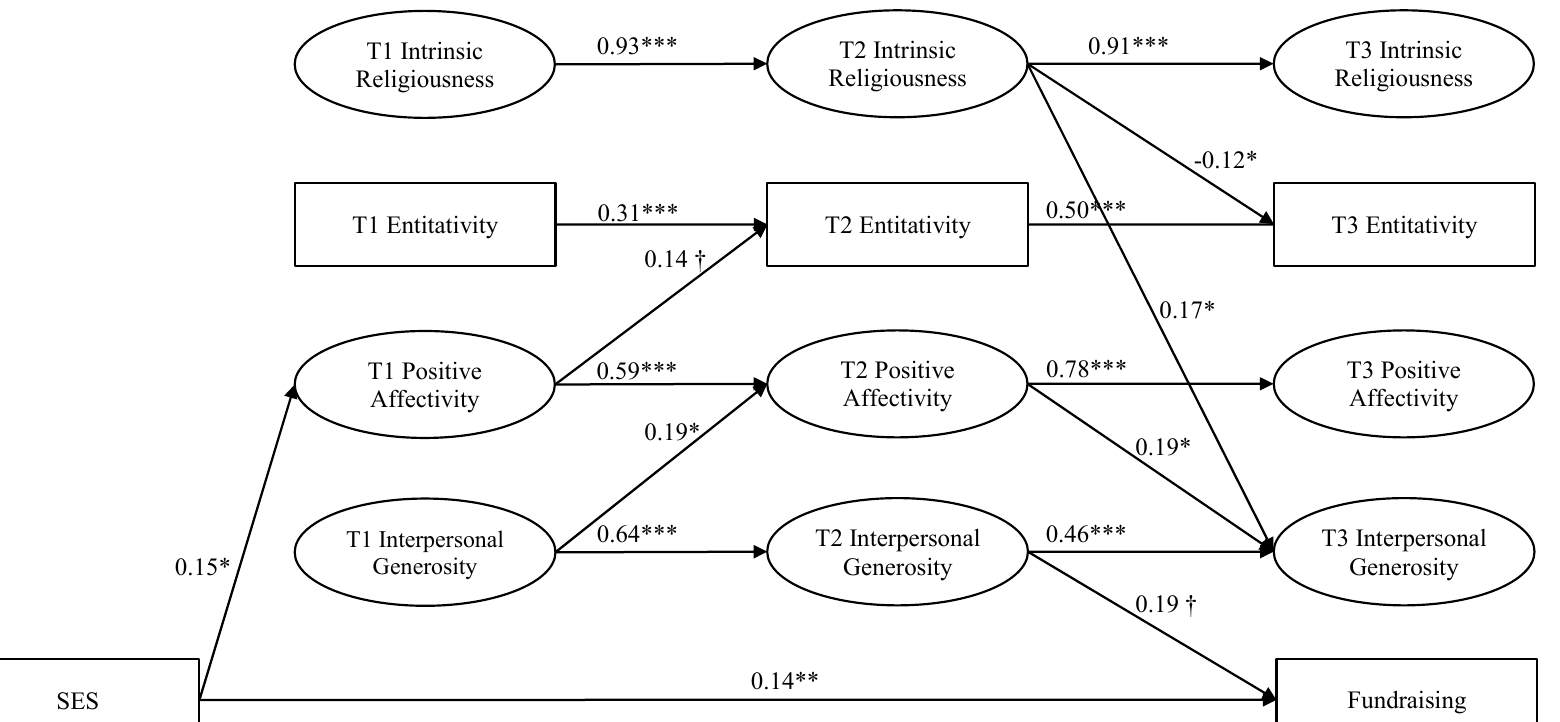
Figure 1. The effects of intrinsic religiousness, group entitativity, and positive affectivity on interpersonal generosity and fundraising across pre-training (T1), mid-training (T2), and post-race (T3). Note. Standardized path coefficients are displayed. For ease of presentation, only significant paths are shown. † p = 0.05, * p < 0.05, ** p < 0.01, *** p < 0.001.